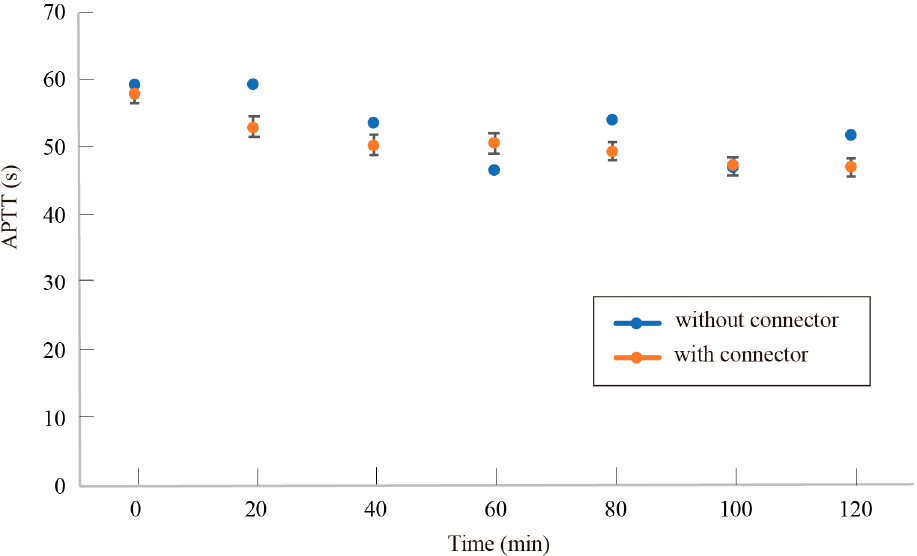
Figure 6. Progress of APTT with and without the connector. No significant differences were induced by the connector during 120 min.